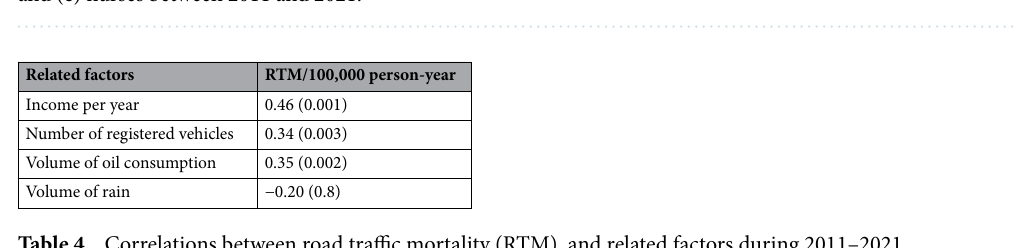
Figure 3. Lorenz curves illustrating equality in distribution of hospital resources and road traffic mortalities (RTMs); ( a ) hospital beds(bed), ( b ) operating rooms (ORs), ( c ) intensive care unit (ICU) beds, ( d ) physicians, and ( e ) nurses between 2011 and 2021.